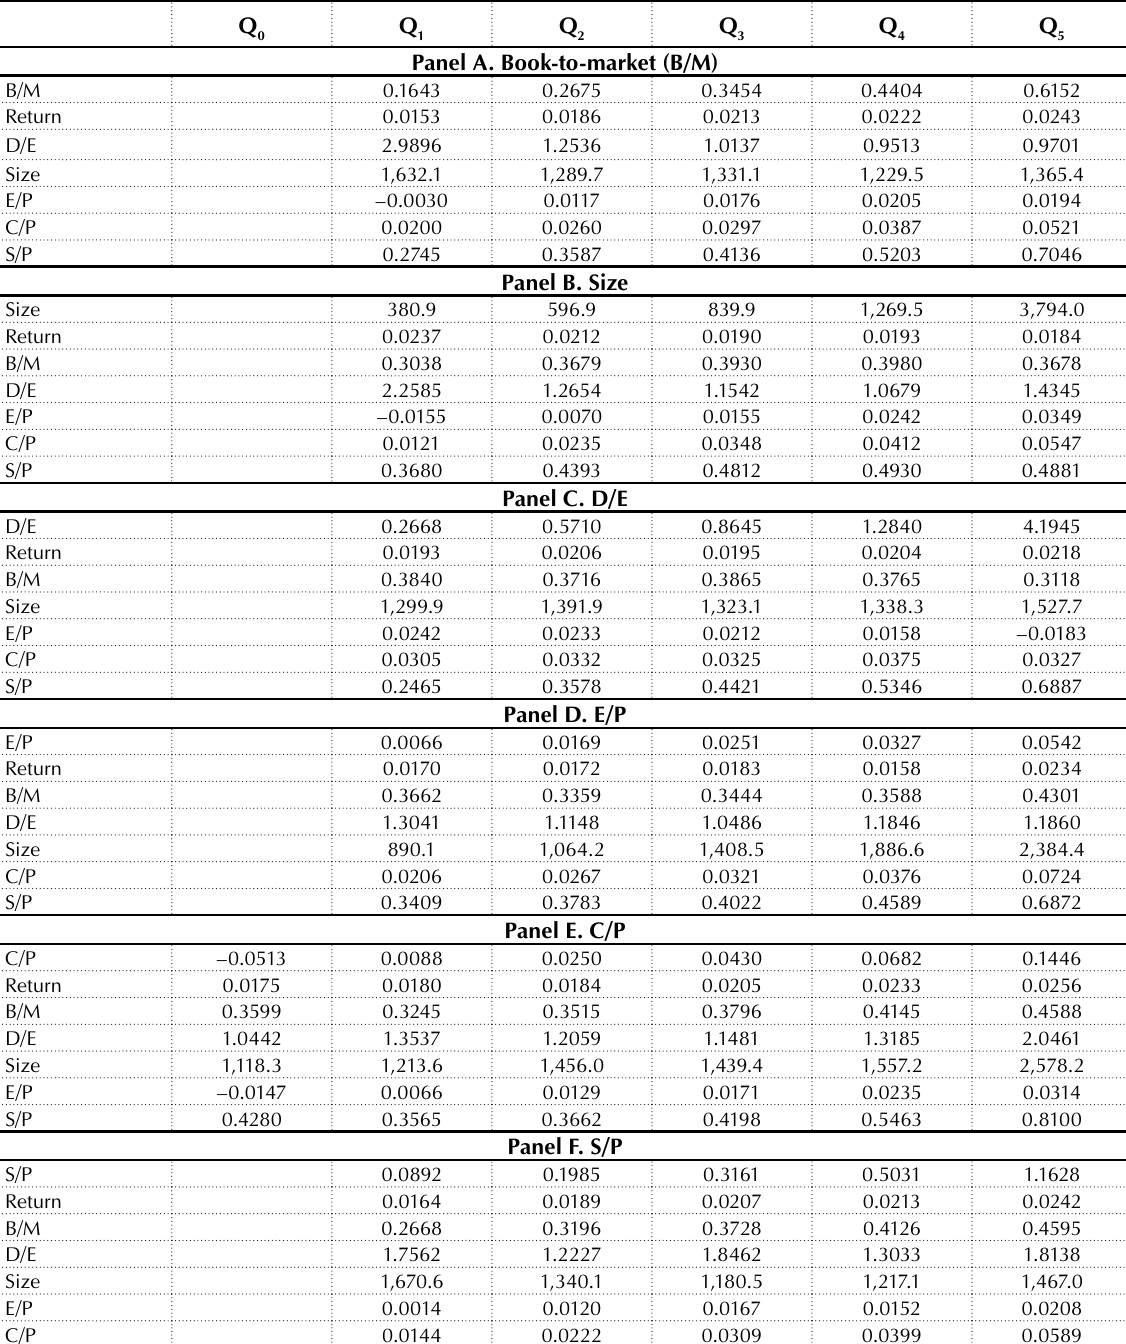
Table 5. Returns and firm characteristics for various characteristic sorts into quintile